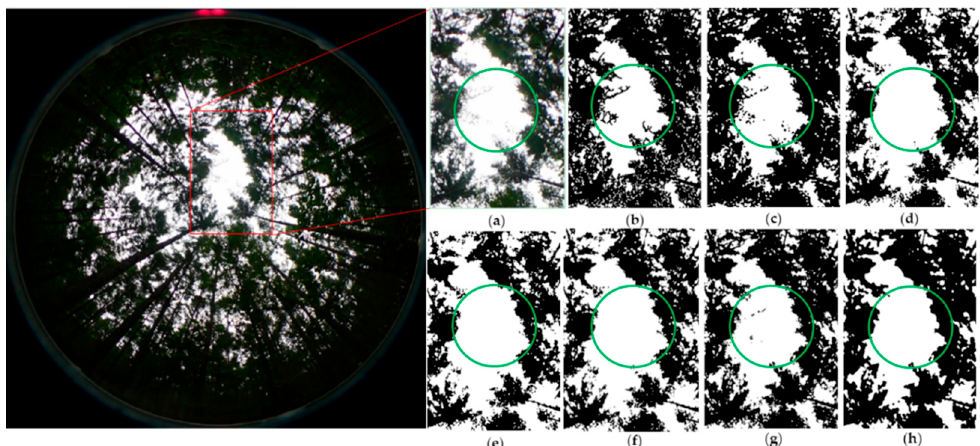
Figure 10. Coniferous forest (Korean pine) canopy local detail comparison (small foliage in the green circles under heavy sunlight). ( a ) Original CHP images; ( b ) manually extracted reference images, segmentation results obtained from ( c ) newly developed U-net method as well as from ( d ) Otsu; ( e ) Ridler; ( f ) fuzzy clustering method (FCM); ( g ) WinSCANOPY; ( h ) Habitat-Net methods. The loss and accuracy curves of the image segmentation model during the training process are shown in Figure 11.